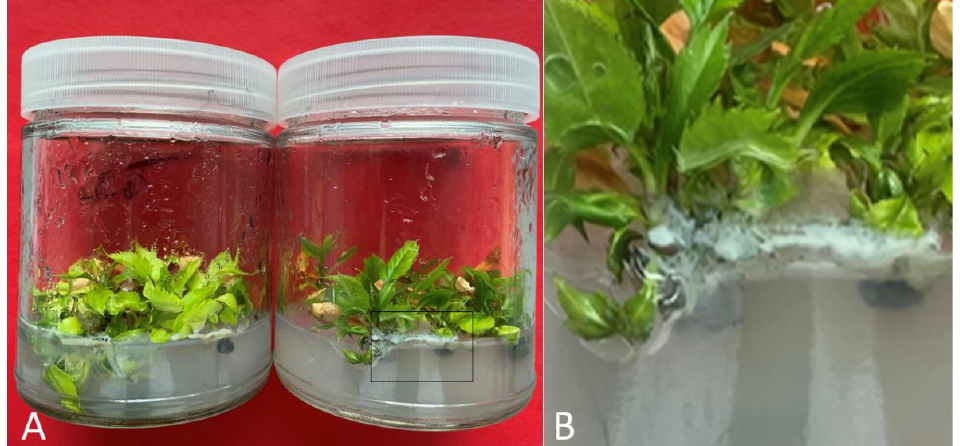
Figure 2. Apple ( Malus spp.) in vitro cultures exhibiting microbial contamination. ( A ) Cultures exhibiting microbial contamination 6 weeks after subculture; ( B ) a closer view of cultures where bacterial colonies have formed around the base of shoots and on the surface of the medium.